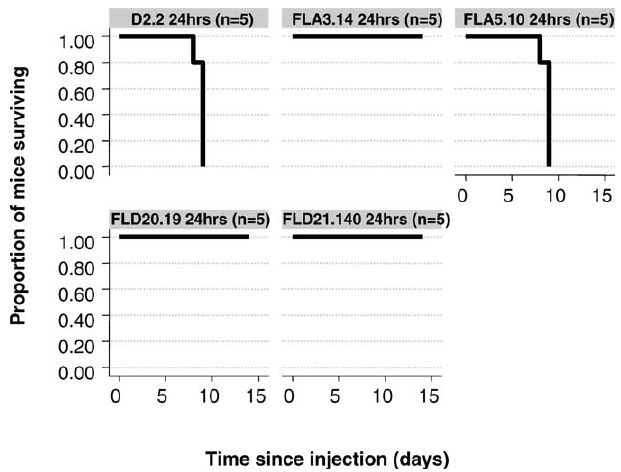
Figure 5. mAb Therapy and Survival in Mice with Established A/ Indonesia/5/2005 (H5N1) Infection The data show the Kaplan-Meier survival curves for groups of BALB/c mice ( n ¼ 5 per group) that were infected i.n. with 5 LD 50 of A/Indonesia/ 5/2005 (H5N1) then 24 h later treated by i.p. injection with the control mAb D2.2, or the anti-H5N1 mAbs FLA3.14, FLA5.10, FLD20.19, or FLD21.140, each at 50 mg/kg body weight. Postinfection therapy at 24 h with mAbs FLA3.14, FLD20.19, or FLD21.140, but not FLA5.10 or D2.2, was associated with absolute protection from lethal infection (FLA3.14, FLD21.140 or FLD20.19 versus D2.2, p ¼ 0.003, log rank